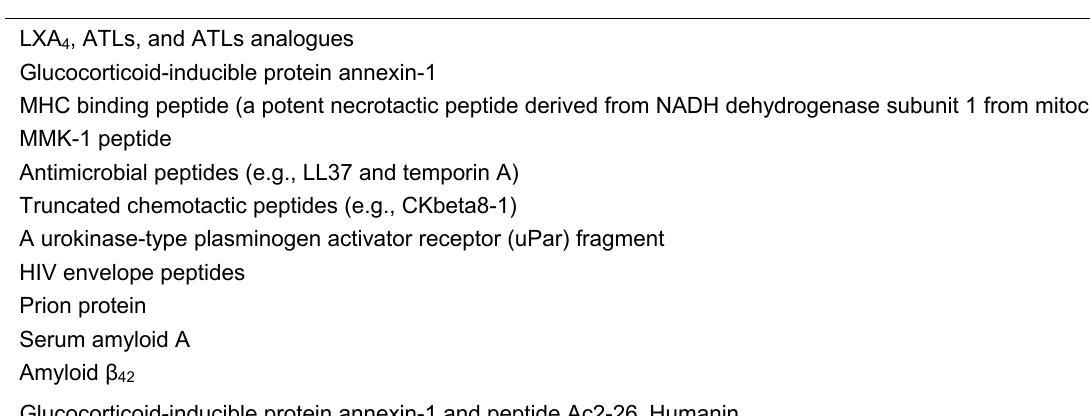
Ligands for Lipoxin